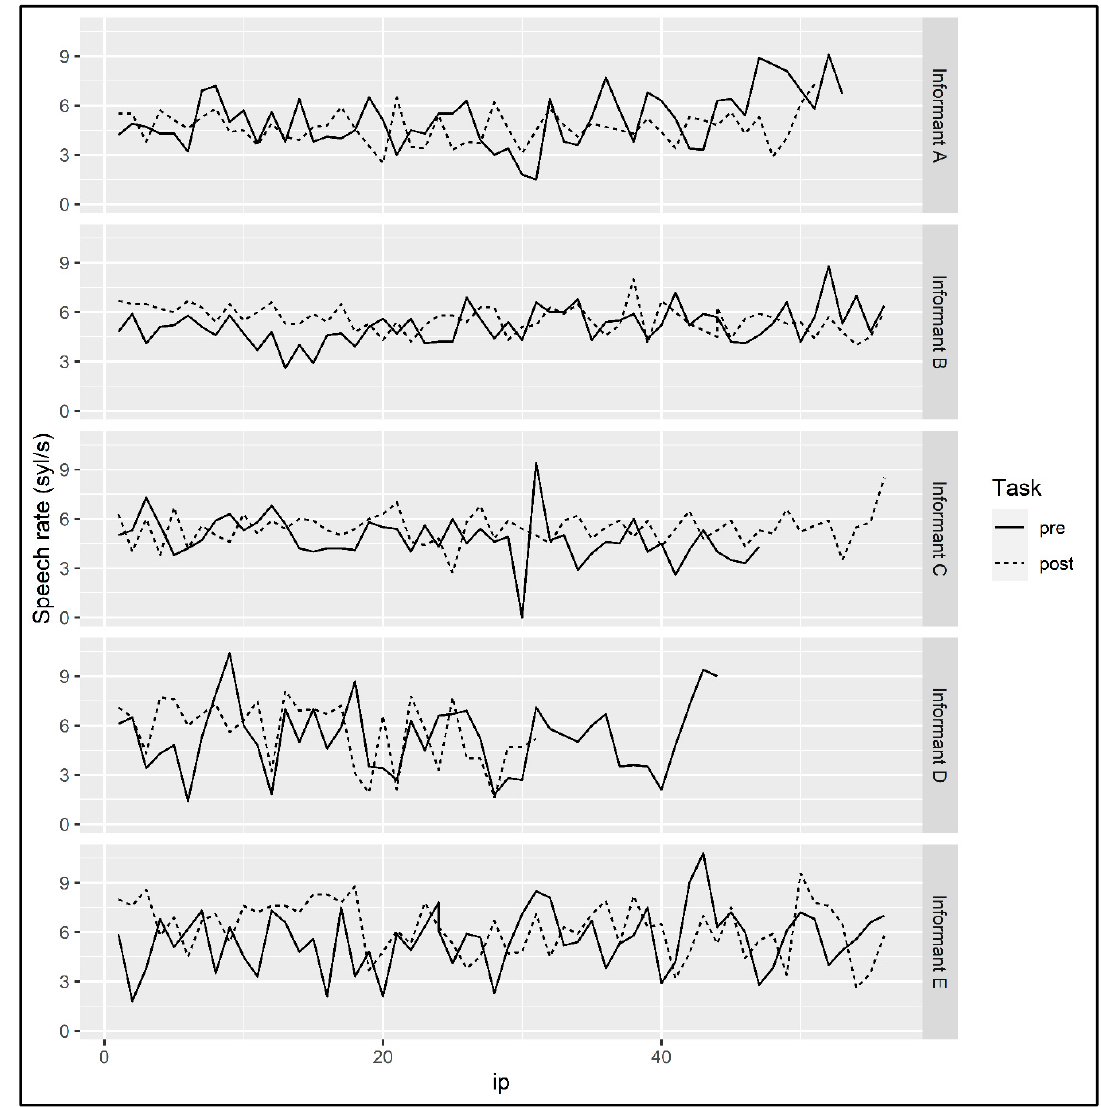
Figure 12. Speech rate measurements over the course of the narrative for each informant.